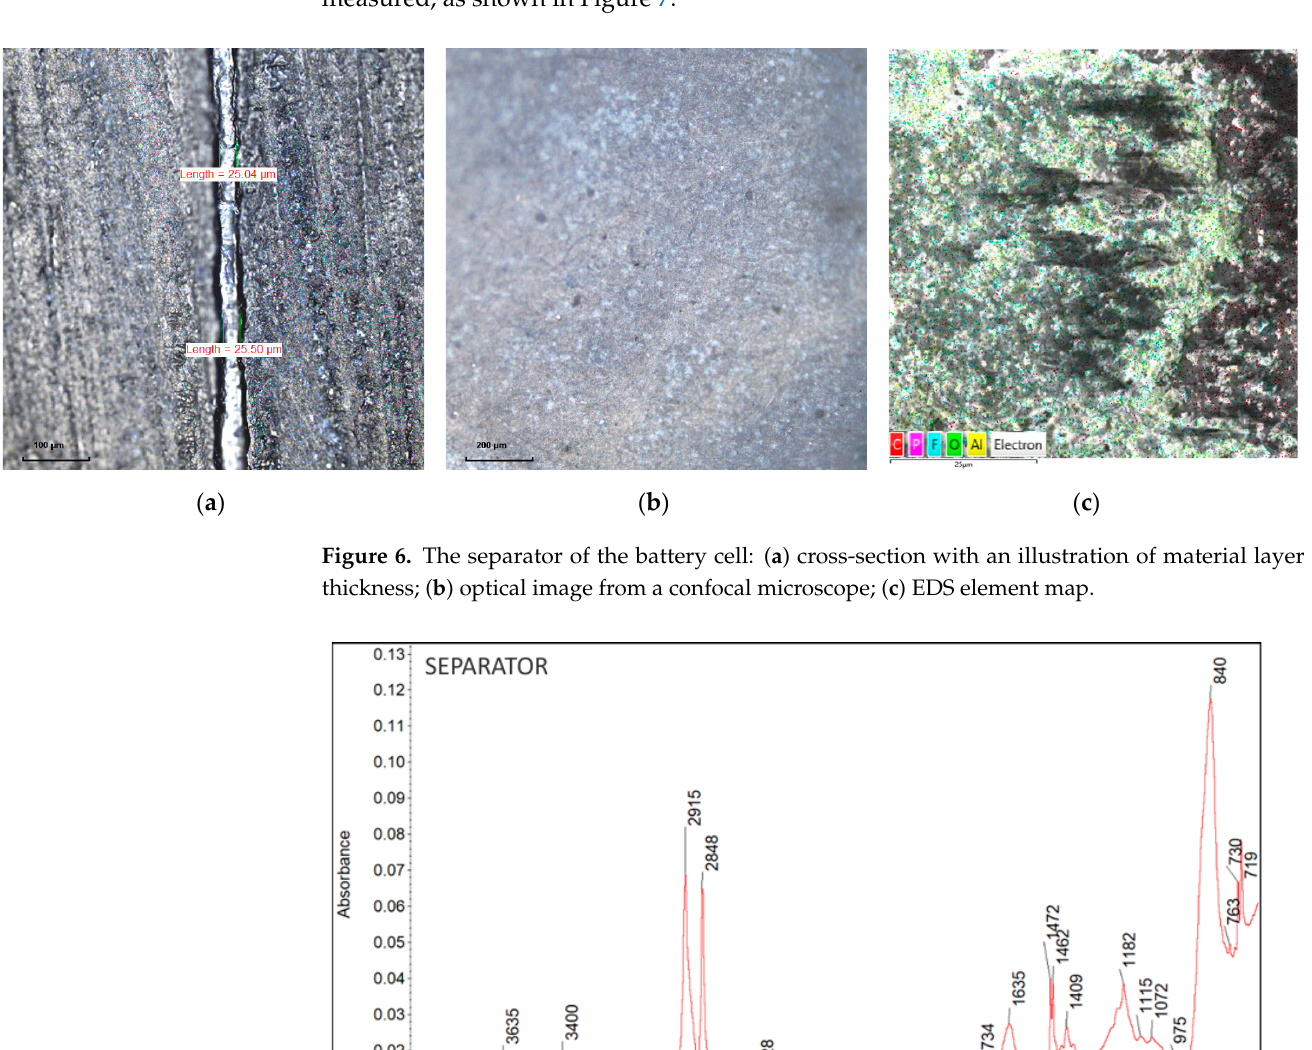
Figure 7. IR spectrum of the